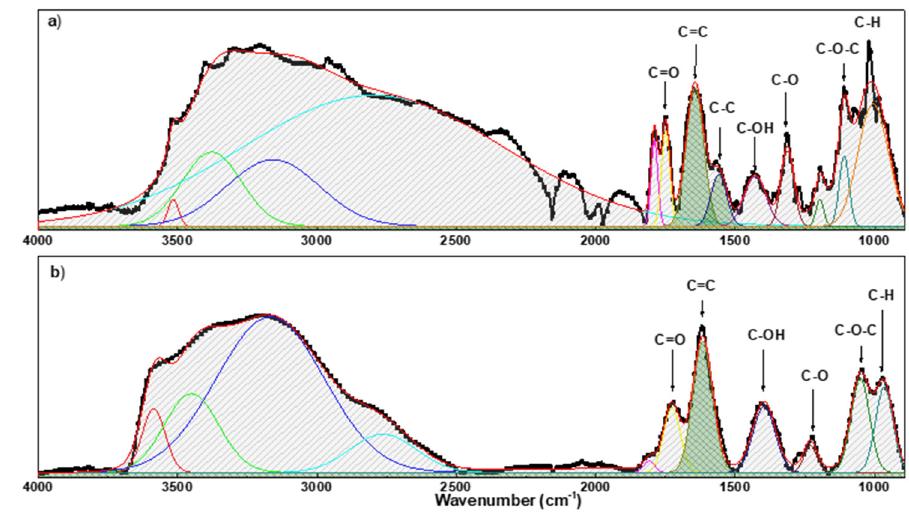
Figure 3. FT-IR spectrum of GO on paper/substrate ( a ) and r-GO on paper/substrate ( b ). Table 3. ATR peaks assignments for GO and r-GO on